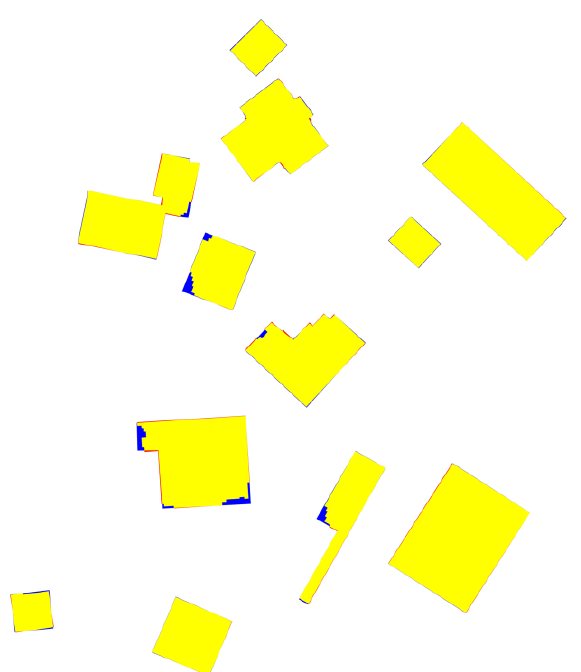
Figure 5. The extracted building outlines obtained by the direct approach from a point cloud with a density of 1 cm (meaning of colours: yellow – true positives; blue – false negatives; red – false